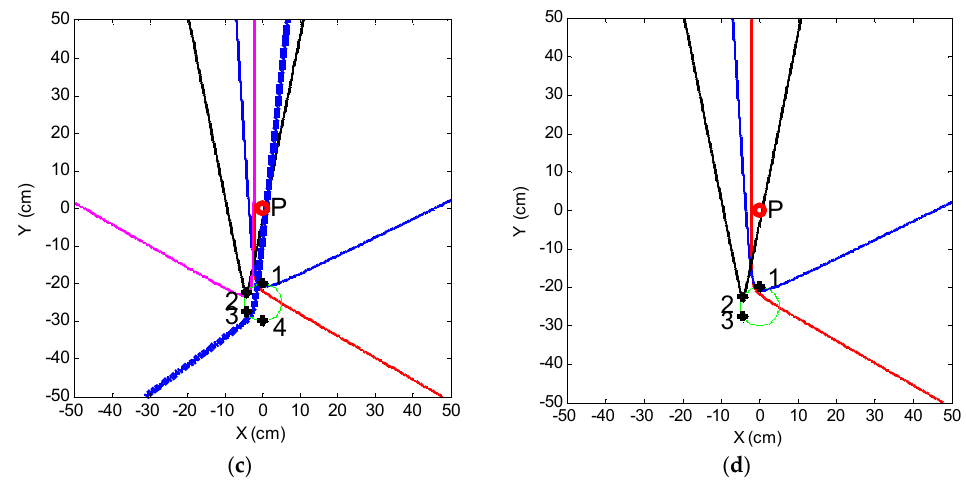
Figure 12. Comparison of the localization results. ( a ) Six sensors; ( b ) five sensors; ( c ) four sensors and ( d ) three sensors.